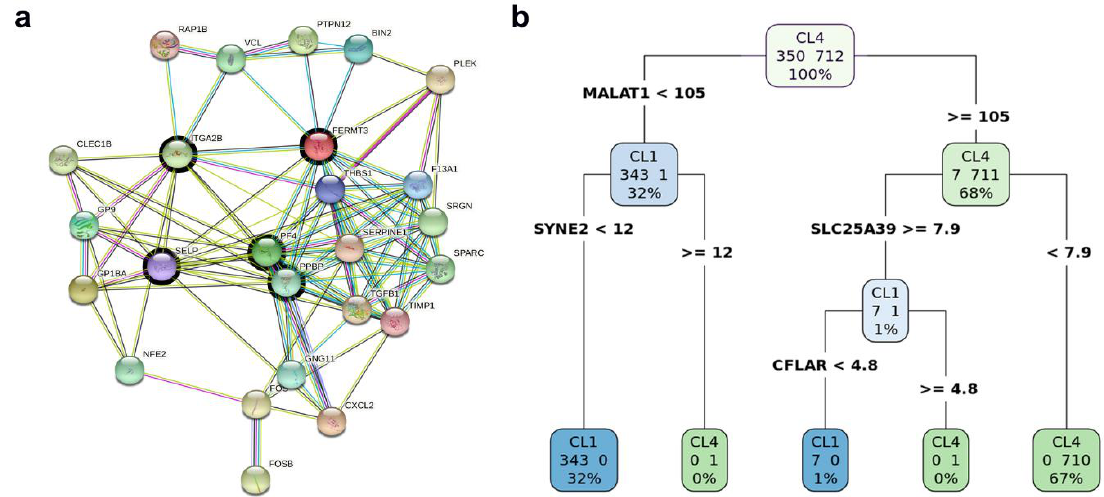
Figure 2. Identification of the circulating tumor cell (CTC) sub-populations, clustered based on the median expression of all genes in at least 10% of the cells. ( a ) t SNE map visualizing clusters of circulating breast cancer cells identified with k - means clustering. ( b ) The plot from ( a ) with cells colored based on their pseudo-time ordering. ( c ) A heatmap portrayal of cell-to-cell distances; cluster centers were ordered by hierarchic clustering. ( d ) The plot from ( a ) with cells colored based on their ESRP1 expression. ( e ) The plot from ( a ) with cells colored based on their TFAM expression. ( f ) The plot from ( a ) with cells colored based on their MALAT1 expression.